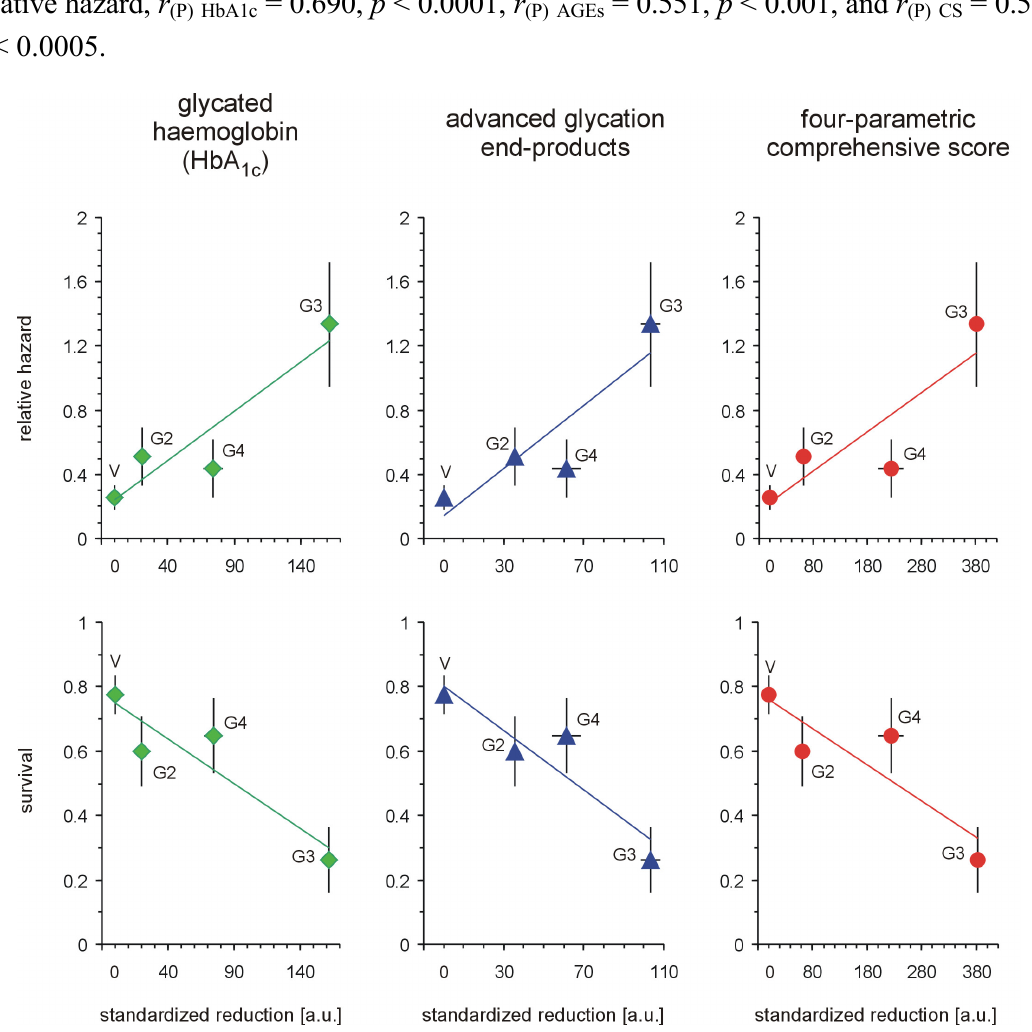
generation-dependent response of rats to treatment with dendrimers, with PAMAM G4 showing the best effectiveness/toxicity ratio and PAMAM G2 showing the worst. Figure 5. Relationships between standardised reductions in hallmarks of severe hyperglycaemia, relative hazard and overall survival in streptozotocin-diabetic rats treated with PAMAM dendrimers. The data, which are presented as the mean ± SEM (n = 5–19), represent the standardised reductions in hyperglycaemia/oxidation markers (per μ mol NH /kg body weight/day) in diabetic Sprague-Dawley rats treated intraperitoneally with 2 PAMAM dendrimers. Kaplan-Meier survival estimates (survival rate and relative hazard) were estimated according to [22] 1 and [23] 2 , respectively (for more details, see Figure 2 and the text). The associations (Pearson’s r ) between HbA , AGEs, CS and overall (P) 1c = − 0.661, p < 0.0001, r = − 0.527, (cumulative) survival were, respectively: r (P) HbA1c (P) AGEs p < 0.002, and r = − 0.550, p < 0.001; between HbA , AGEs, CS and cumulative (P) CS 1c relative hazard, r = 0.690, p < 0.0001, r = 0.551, p < 0.001, and r = (P) HbA1c (P) AGEs (P) CS